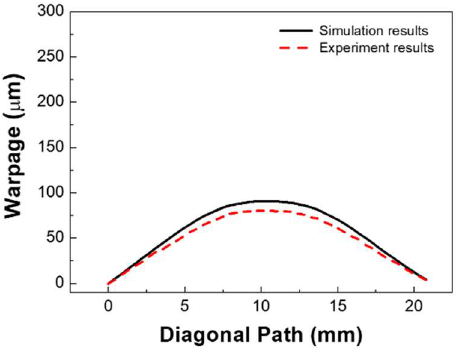
( b ) Figure 12. ( a ) Measurement results of the warpage of the flexible package, and ( b ) numerical simu- lation results of the warpage of the flexible package. Figure 13 shows the results of a comparison of the warpage behavior between the experimental results and the simulation results of the flexible package. It was found that the flexible package was deformed in a convex (∩) or crying shape after the bonding pro- cess. The warpage behavior in the simulation results was in good agreement with that of